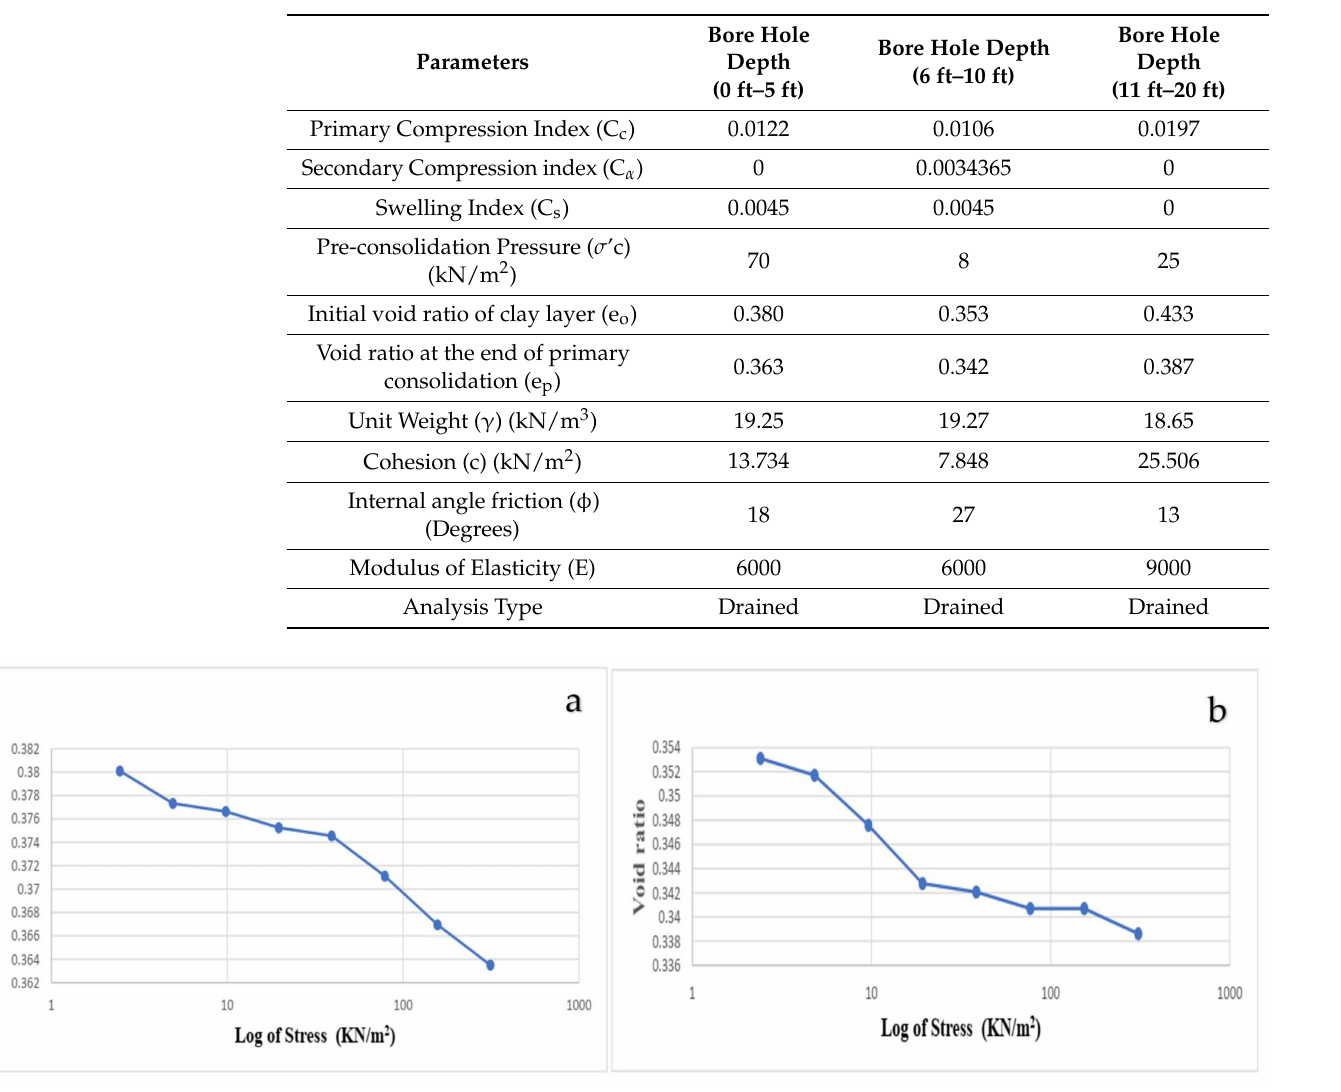
Table 2. Basic parameters of soil.